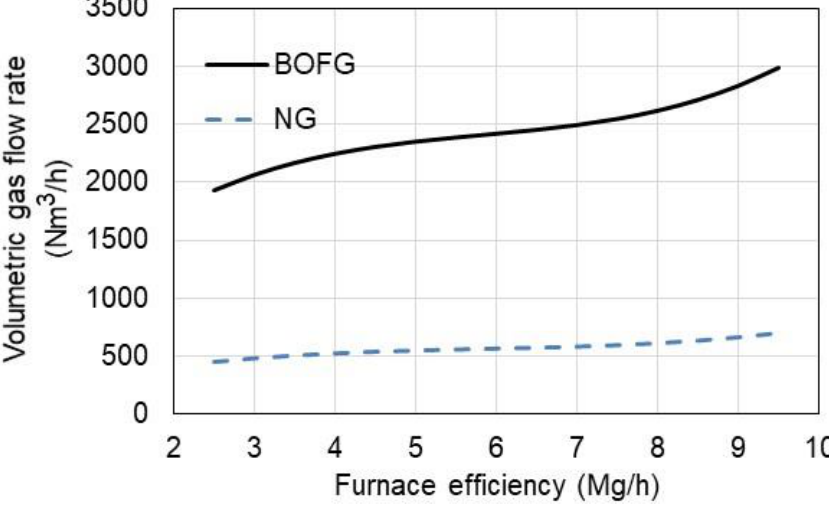
Figure 7. Gas consumption vs. furnace efficiency.